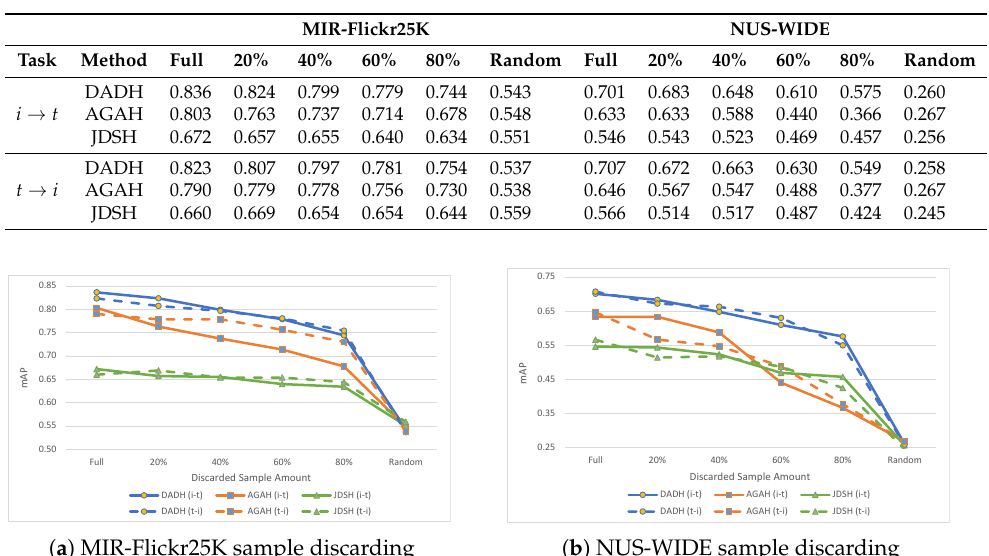
Figure 9. Results (mAP) on MIR-Flickr25K and NUS-WIDE with sample discarding, i.e., training set being reduced. The ‘Full’ points show results when training with the full unaltered training set. Subsequent points show results with decreasing amounts of samples, where the given percentage denotes the percentage of samples in the training set which have been discarded. The ‘Random’ points hold the baseline random performance